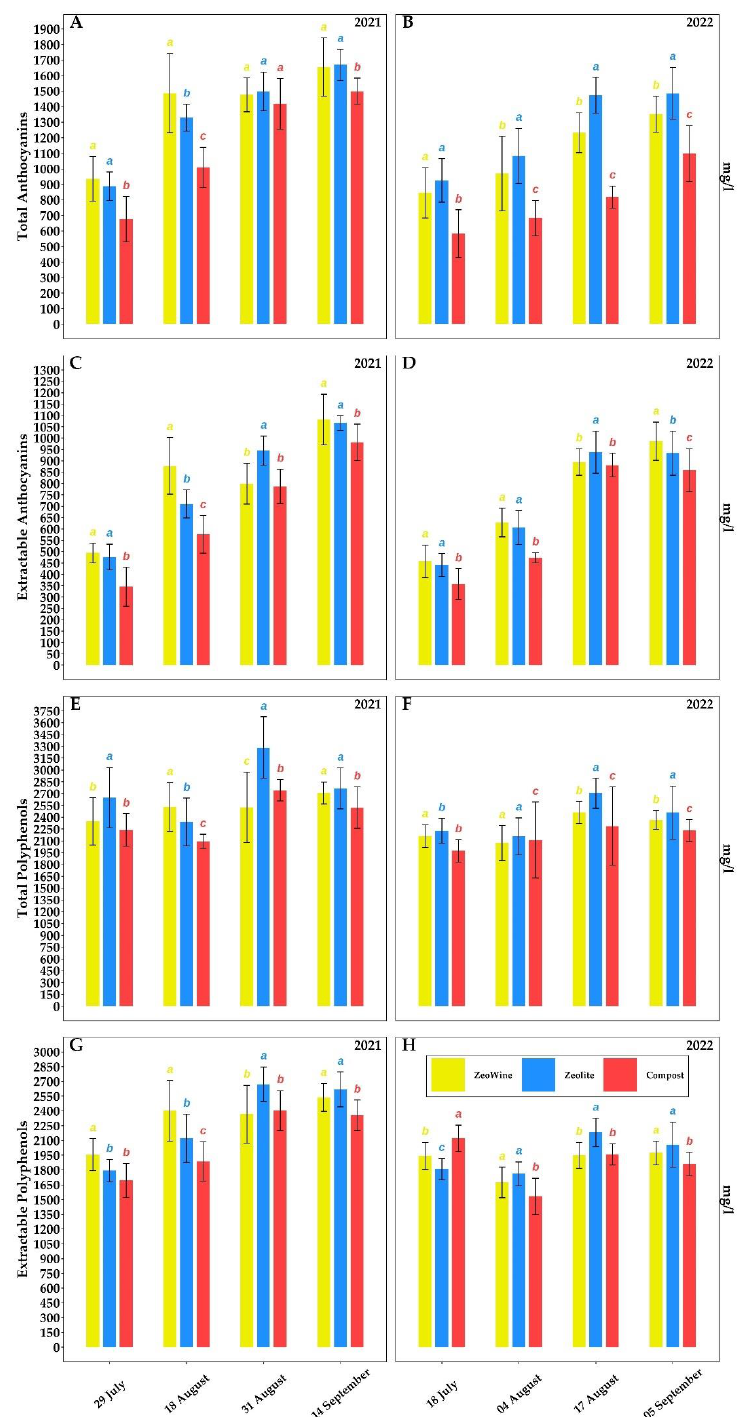
Figure 7. Phenolic maturity. Total and extractable anthocyanins, total and extractable anthocyanins of Vitis vinifera treated with Zeowine, Zeolite, and Compost during two seasons (2021–2022, ( A )–( H